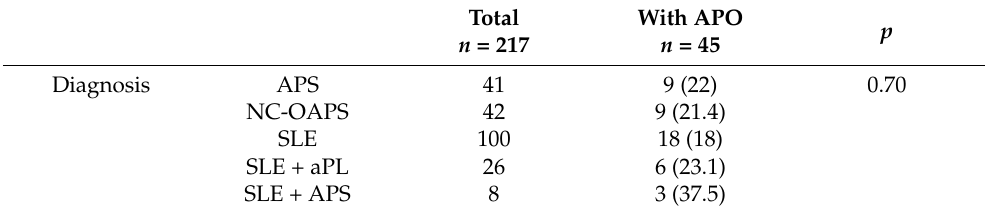
Table 1. Distribution of pregnancies included and incidence of APO according to the diagnosis.